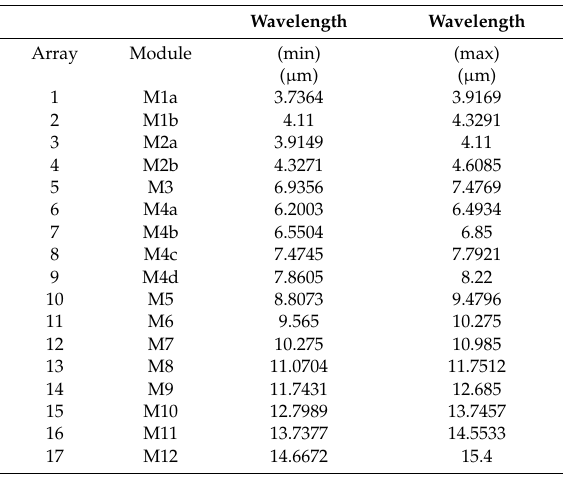
Table 1. Module spectral regions.